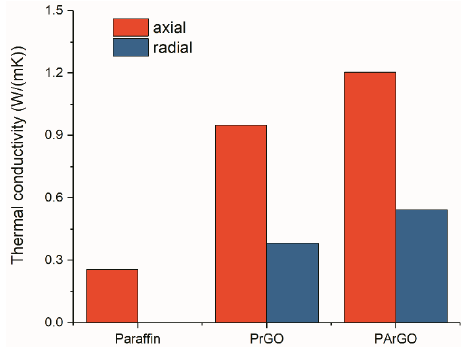
Figure 6. Thermal conductivity of paraffin and composite PCMs.